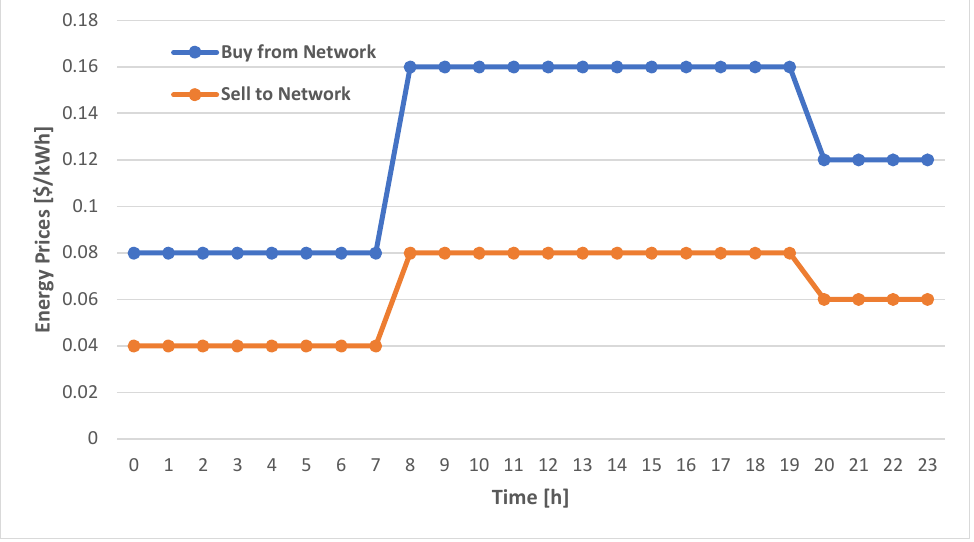
Figure 5. The used raw historical energy